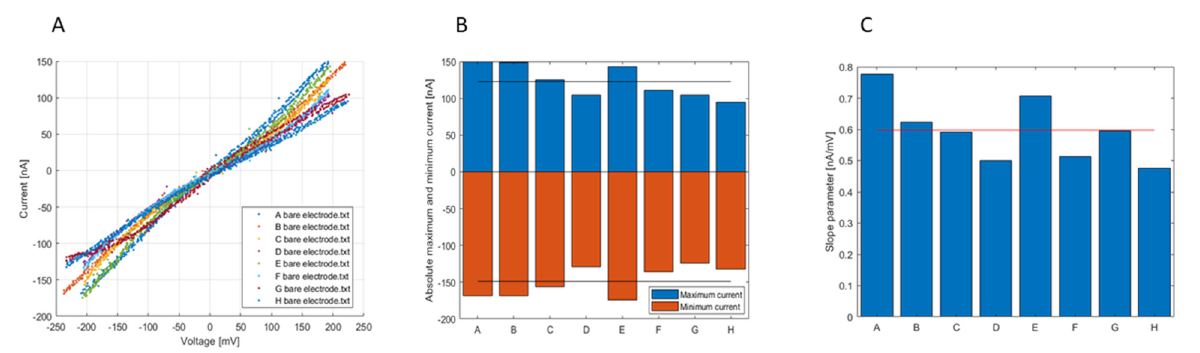
Figure 4. ( A ). CV curves for each channel of the device. Characterization of bare gold electrodes. ( B ) Absolute maximum (blue) and minimum (red) currents histogram for each device channel, values from Figure 4A. The black lines are for the mean values. ( C ) Fitted slope parameters histogram CV curves in Figure 4A, the red line is for the mean value.